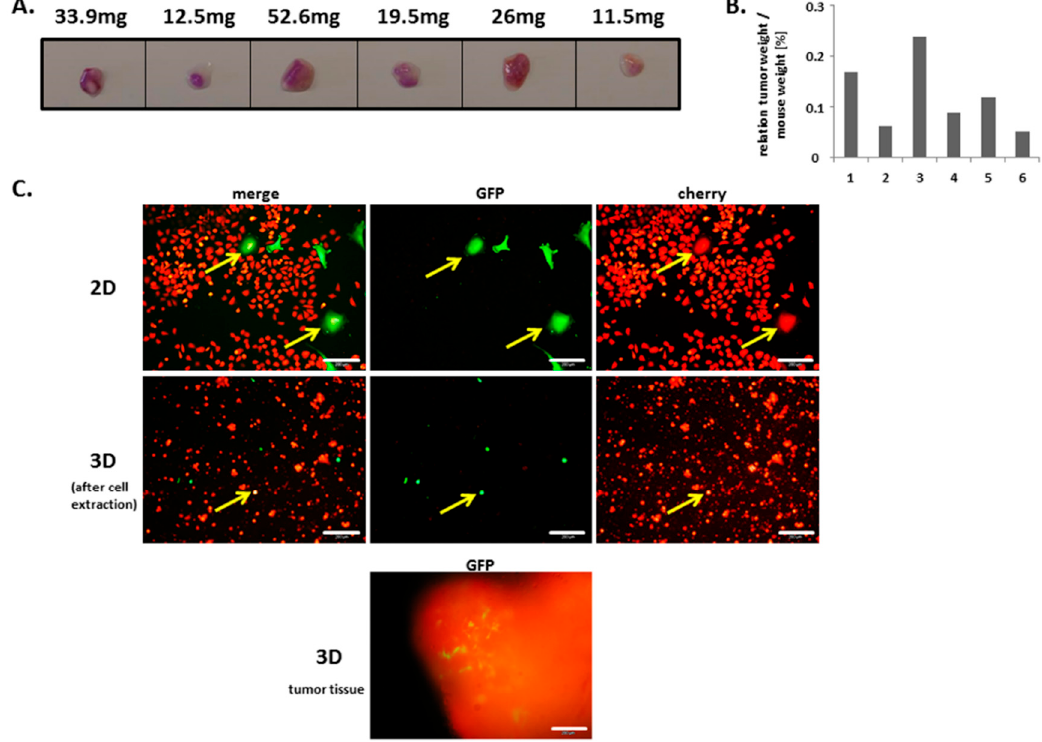
Figure 3. ( A ) In vivo formation of hybrid cells during tumor development was tested after subcutaneous co-injection of 10 6 human MSC290115 GFP together with 10 6 MDA-MB-231 cherry breast cancer cells in NOD/scid mice for 14 days. ( B ) Ratio of mouse weight to tumor weight was compared between 6 tumors from 3 NOD/scid mice. ( C ) Formation of hybrid cells as indicated by yellow arrows was detectable by fluorescence microscopy in both, 2D in vitro co-cultures (upper panel) and in 3D ex vivo tumor tissues following extracellular matrix digestion and cell isolation (middle panel). In vivo presence of MSC290115 GFP in tumor tissues after 14 days is exemplarily documented (lower micrograph). Bars represent 200 µm.